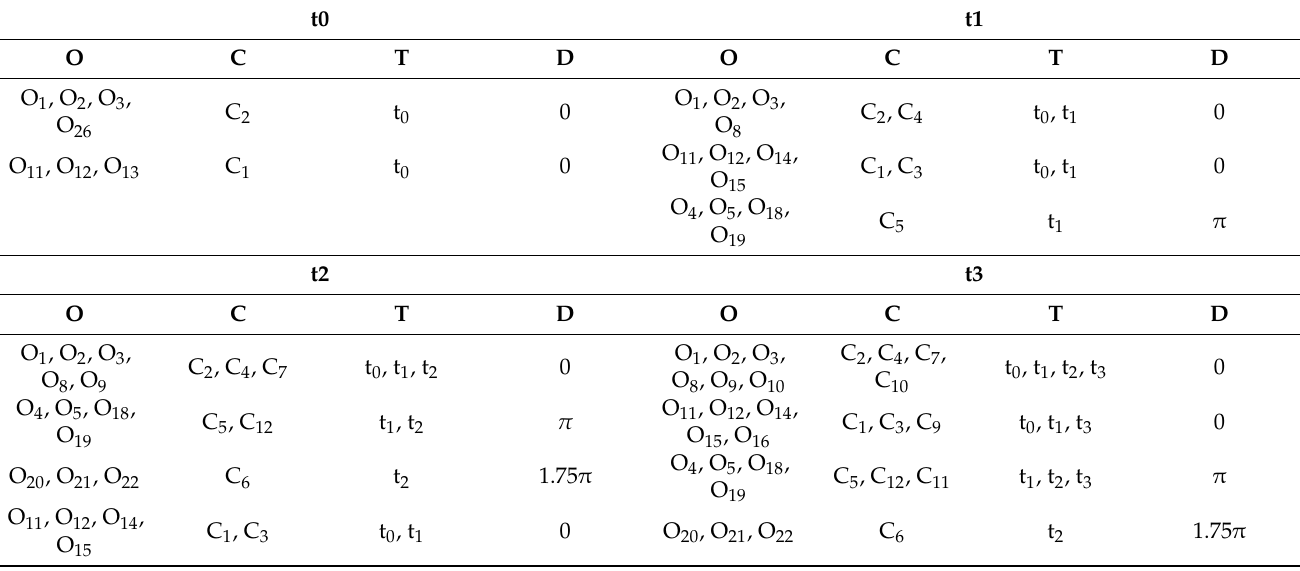
Table 1. Example of discovery of loosely moving congestion